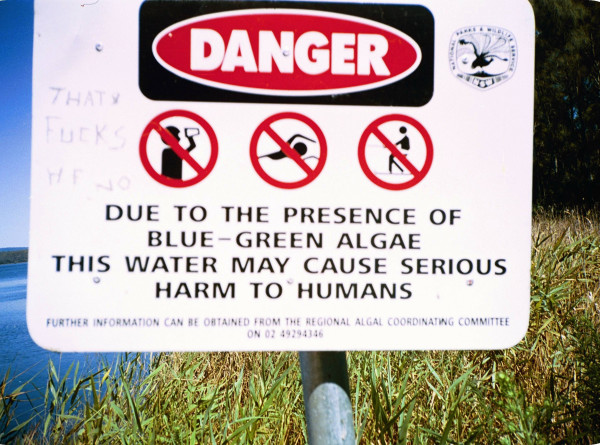
Example of an Australian cyanobacteria warning sign posted at a recreational water site (with a concise, eloquent but anonymous critique of the message?).